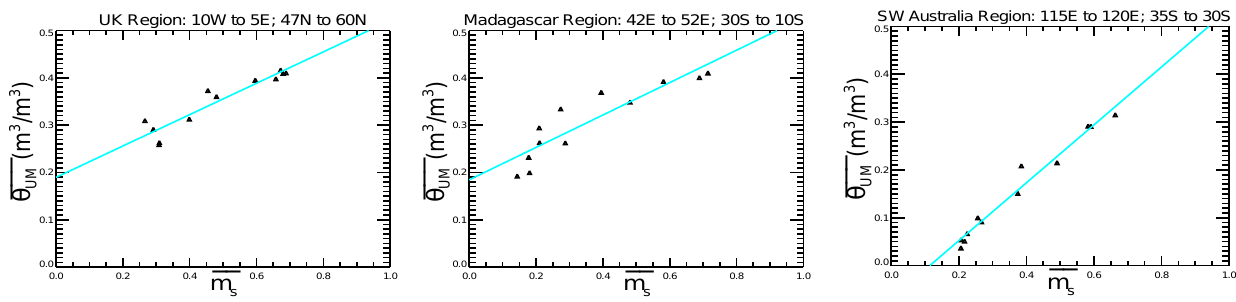
Fig. 2. Plots of UM level 1 volumetric soil moisture monthly climatology θ UM vs. the ASCAT surface soil wetness monthly climatology m s for the UK region (10 ◦ W to 5 ◦ E; 47 ◦ N to 60 ◦ N), Madagascar region (42 ◦ E to 52 ◦ E; 30 ◦ S to 10 ◦ S) and SW Australia region.(115 ◦ E to 120 ◦ E; 35 ◦ S to 30 ◦ S). Each plot contains 12 data points, one data point for each month of the